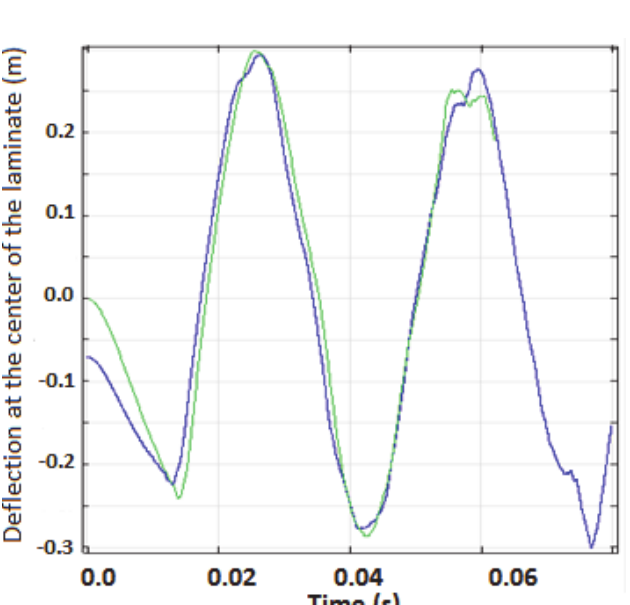
Fig. 1: comparison between the laminate deflection at its center calculated: 1) using a model with 3 plies having the glass modulus set to 10Mpa after glass breakage (blue curve) and 2) a model using one single ply model the broken laminate (green